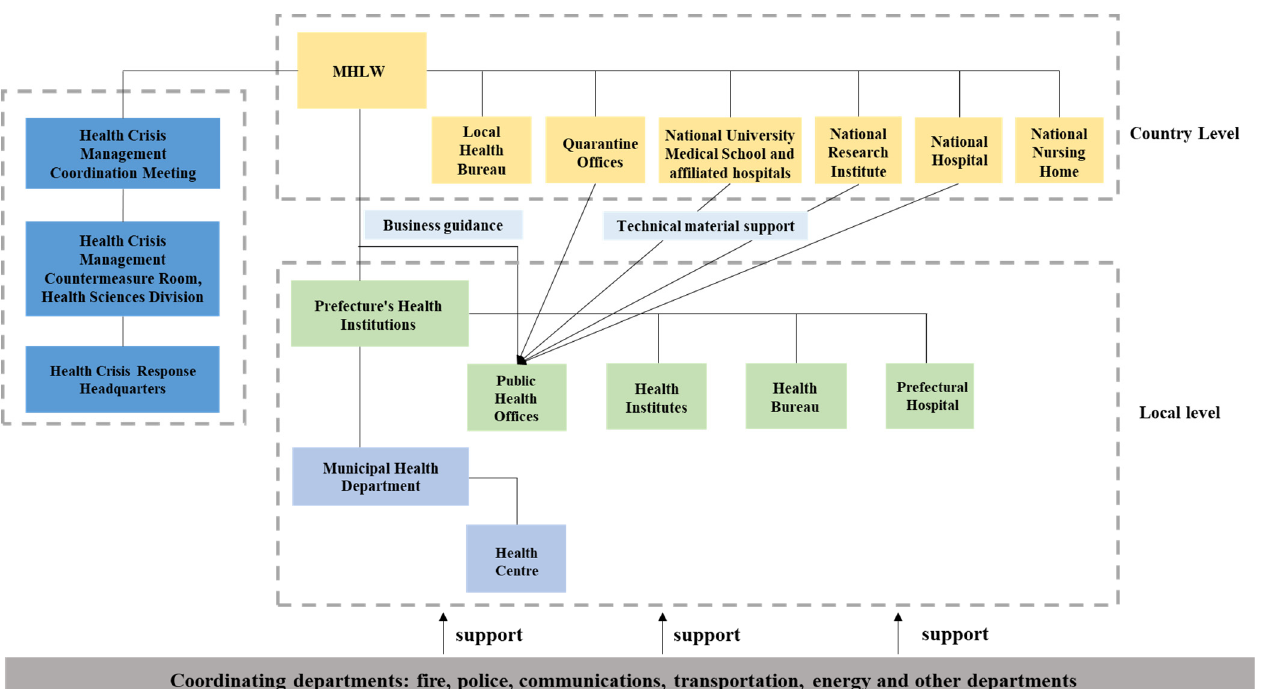
Figure 3. Japan’s public health emergency management system.